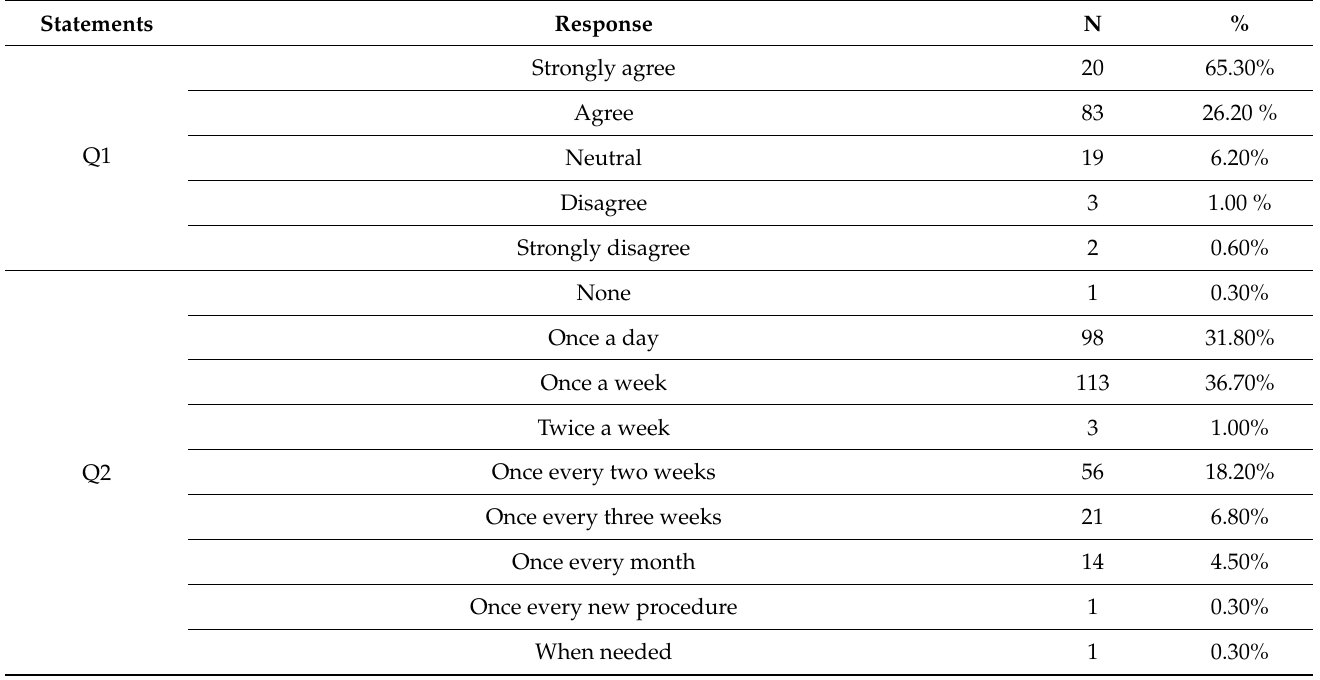
Table 2. Details of the questions related to the usage of